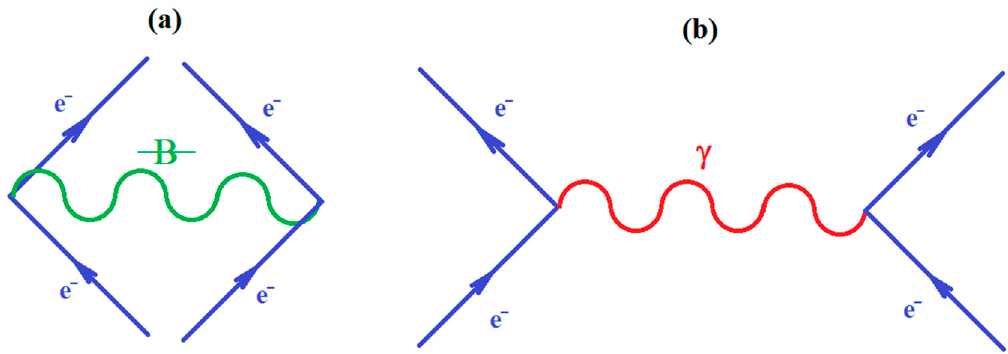
Figure 1. ( a ) The Feynman like diagram of inter-electronic pairing through the “gluing bondon” in chemical bonding; ( b ) The standard Feynman diagram of inter-electronic repulsion through “exchanging the photon” in free state.